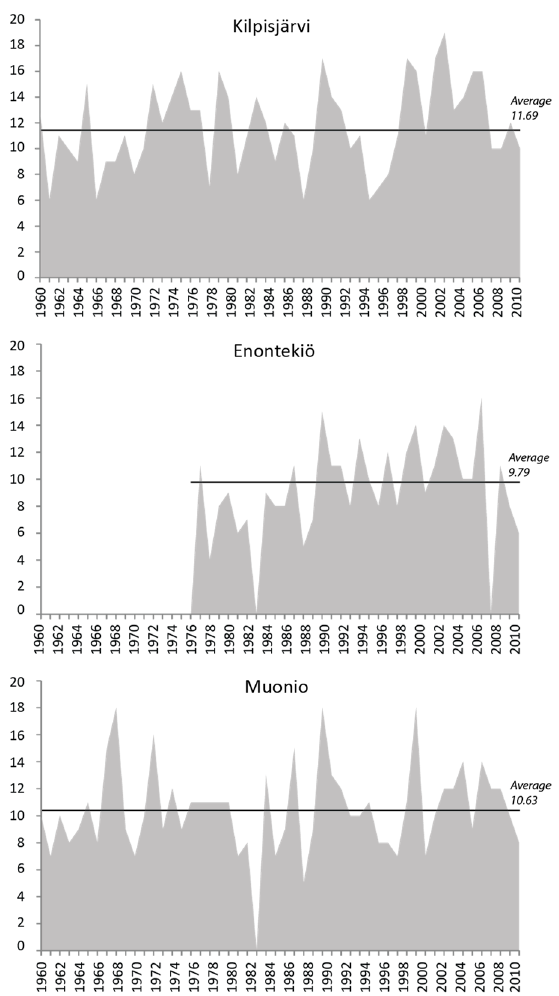
Figure 8. Number of frost and thaw cycles based on the daily average temperatures at Kilpisjärvi, Enontekiö and Muonio, 1960–2011. Enontekiö and Muonio,